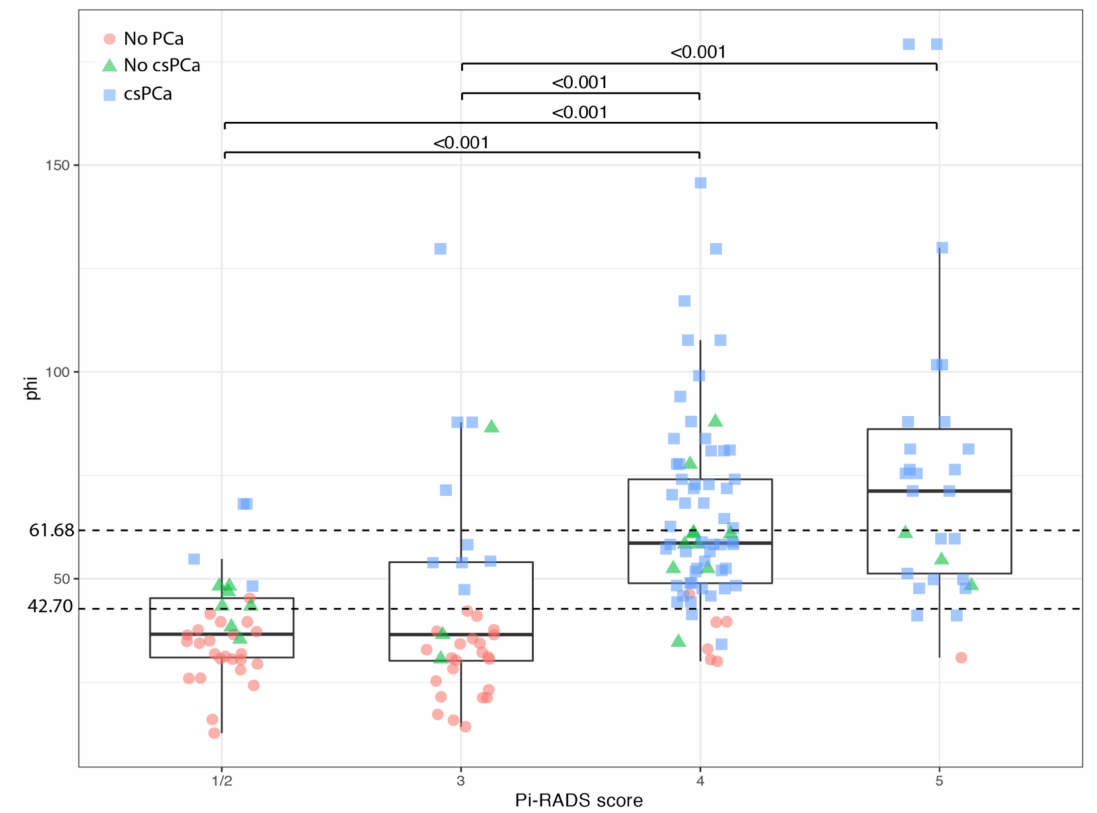
Figure 3. Boxplot showing distribution of PHI according to PI-RADS v2 score. Dashed lines indicate cut-off values. Data are shown as median (bold horizontal line in the box) and Q1 and Q3 (borders of the box). Whiskers represent the lowest and the highest values that are not outliers (i.e., data points below Q1 − 1.5 × IQR or above Q3 + 1.5 × IQR). Outliers are those outside the whiskers. Q1 = 25th percentile; Q3 = 75th percentile; IQR (interquartile range) = Q3 − Q1; csPCa, clinically significant prostate cancer; PI-RADS, Prostate Imaging Reporting and Data System; PHI, prostate health